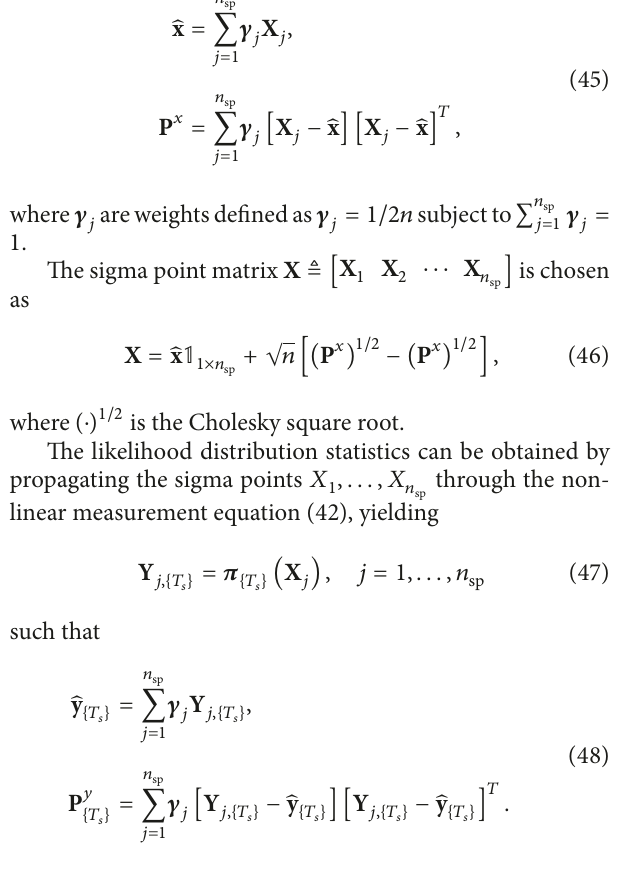
Algorithm. The UKF algorithm is formed by a forecast and